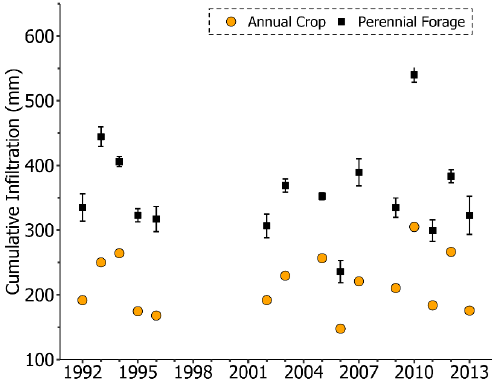
Figure 7. Comparison of annual infiltration depth between annual crop and forage simulations for the La Salle River subbasin (LS- 05OG008). Error bars indicate the 95% confidence interval of the forage simulation ensemble. The years 1997–2001, 2004, and 2008 were not used for model assessment due to missing data or equip- ment